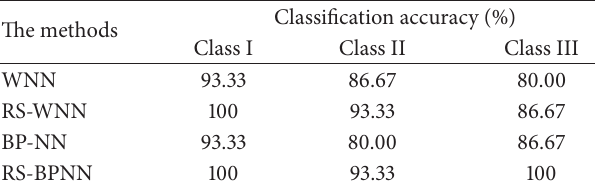
Table 6: Classification results of the four